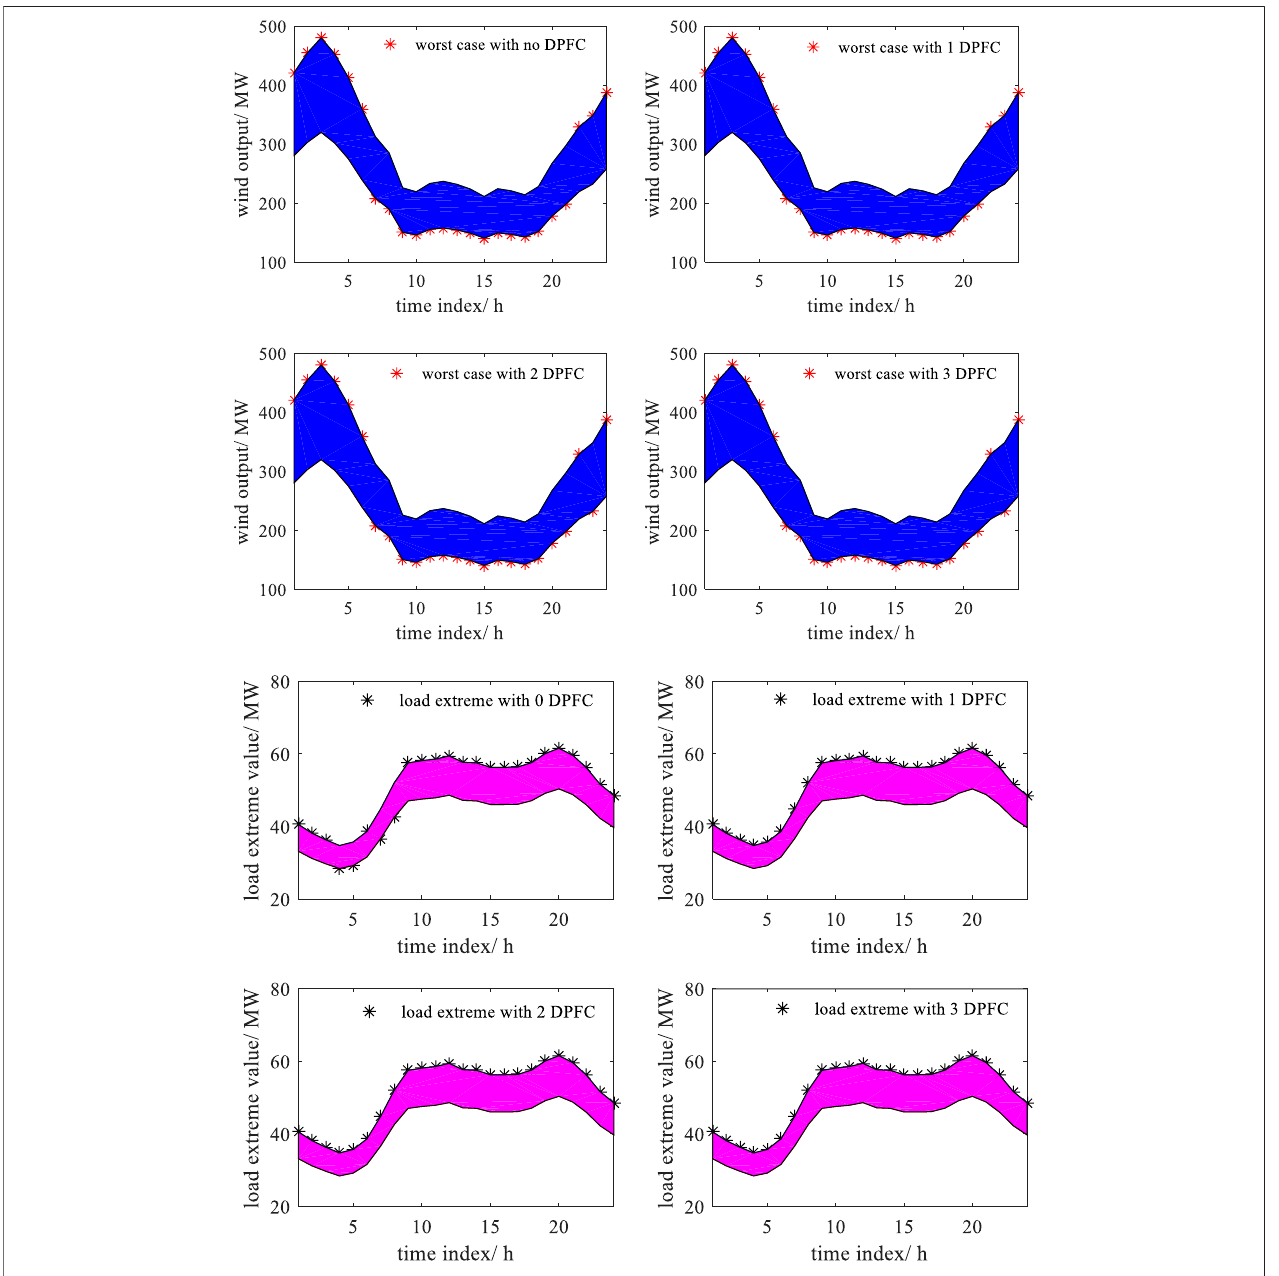
FIGURE 10 | Wind/load upper/lower bound and its worst-case scenario with different numbers of the DPFC.